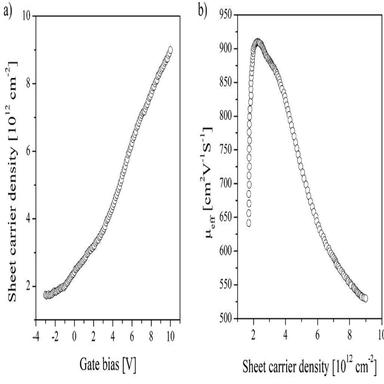
a) Sheet carrier density of the InAs shell as a function of gate bias, the gate bias was scanned from − 3V to 10 V, b) field-effect electron mobility is plotted versus carrier density.